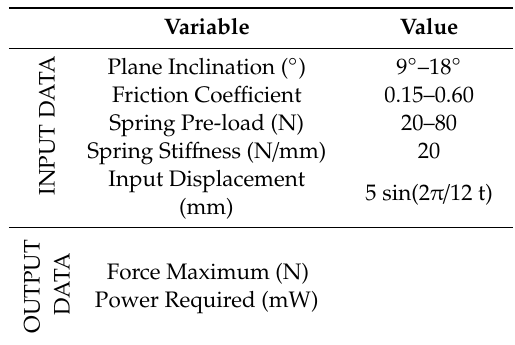
Figure 2. Multibody model of the pin unlocking mechanism. Table 1. Details of multibody model